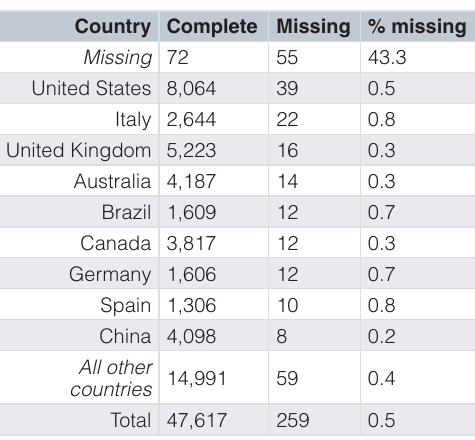
Table 1. Number of complete and missing affiliation data by country for the top ten countries. “Missing” is included as a nominal country, that is the affiliation and country data were both missing. Countries ordered by number missing.